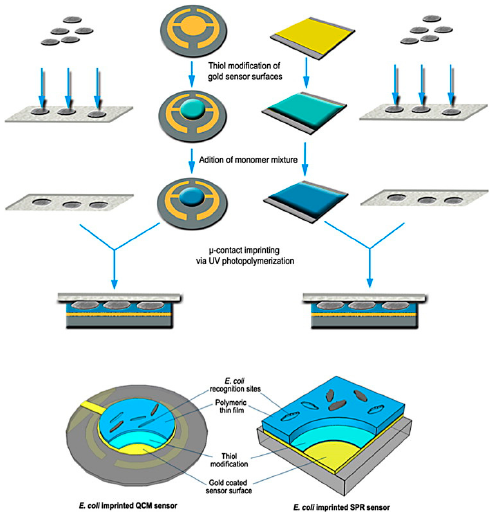
Figure 14. Schematic representation of micro-contact imprinted SPR and QCM sensor surfaces (adapted with permission from [60]).